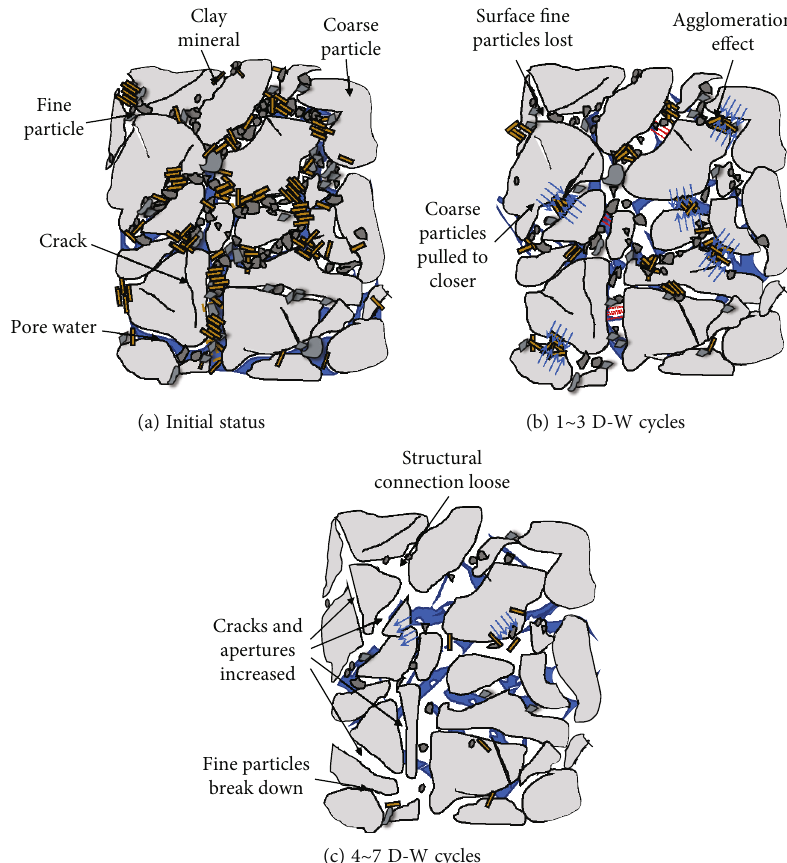
Figure 13: Microstructure changes of GRS with D-W cycles under dynamic